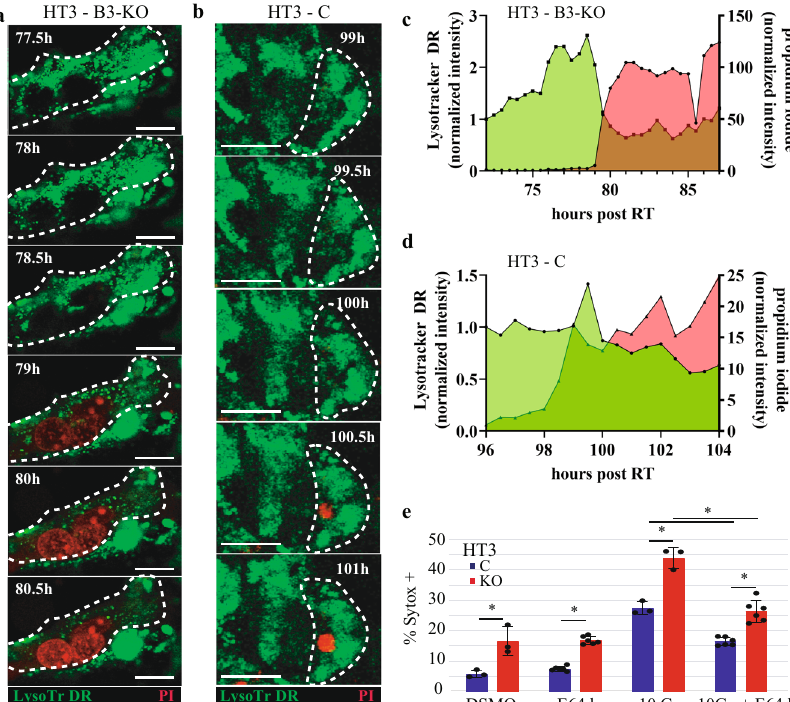
Fig. 6 Radiation induces loss of lysosomal membrane integrity that precedes cell death. a , b Live-cell time-lapse confocal pseudocolor images of HT3- B3-KO ( a ) and HT3-B3-WT ( b ) cells at the indicated times after treatment with 10 Gy RT. LysoTracker deep red is pseudo-colored green and propidium iodide is pseudo-colored red. Scale bar = 25 μ m. c , d cells shown were manually tracked over the timeframe indicated on the x -axis and intensity of LysoTracker deep red (LysoTr) and propidium iodide normalized to cell volume is plotted on the double y -axis. e Percent Sytox-positive HT3-B3-WT and – B3-KO cells treated with vehicle DMSO or E64d 24 h after sham or 10 Gy radiation. * = p < 0.05 by double-sided t -test. Each data point represents the % Sytox-positive quanti fi ed in 2 – 4 fi elds of view of one triplicate well ( n = 3 per condition), and is a representative one of three biologic replicate experiments. Mean indicated by bar height and error bars show standard